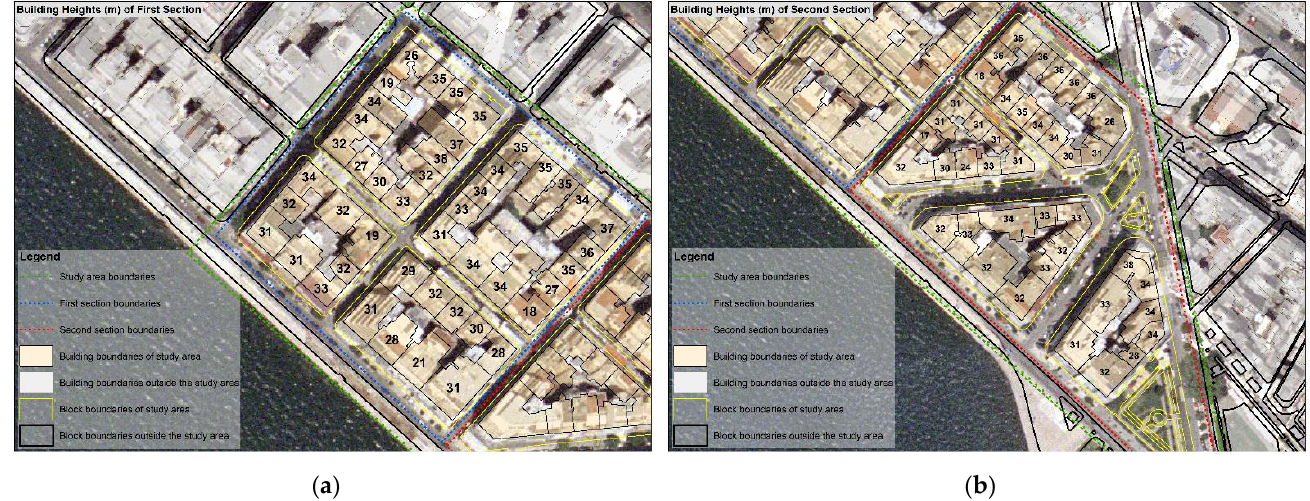
Figure 4. ( a ) Building heights (in meters) of the first section; ( b ) Building heights (in meters) of the second section (the numbers from the heights have been rounded), ArcGIS software (basemap: orthophoto Cadastral SA).